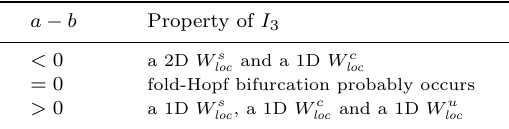
Table 4. The behaviour of I 3 in the local chart U 3 . a − b Property of I 3 c < 0 a 2D W s loc and a 1D W loc = 0 fold-Hopf bifurcation probably occurs >